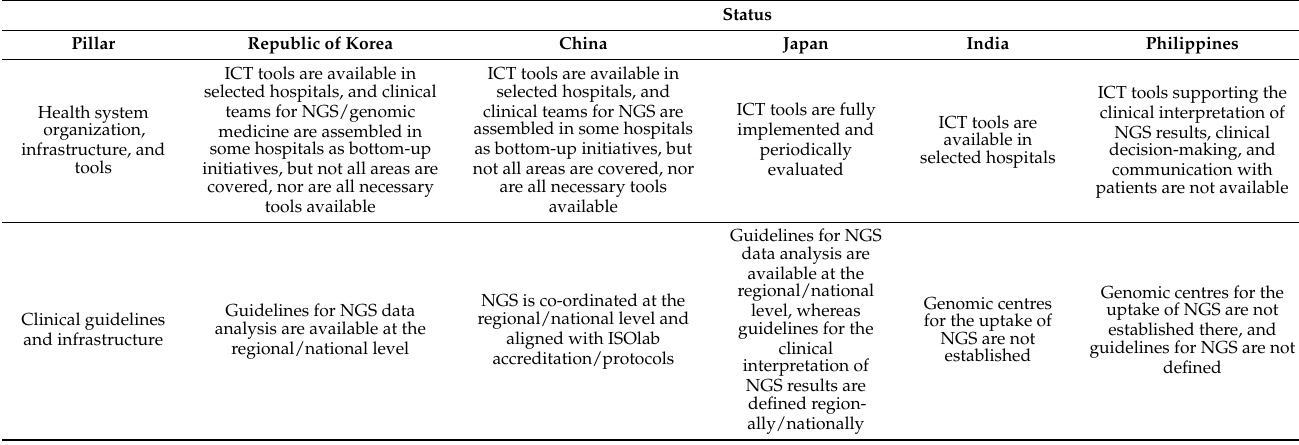
Table A5. Status of NGS maturity levels for a few countries from